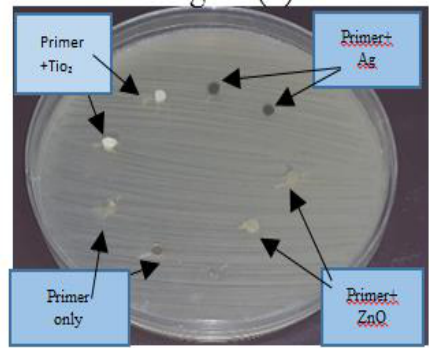
Figure 4: The discs placed inside the BHI agar